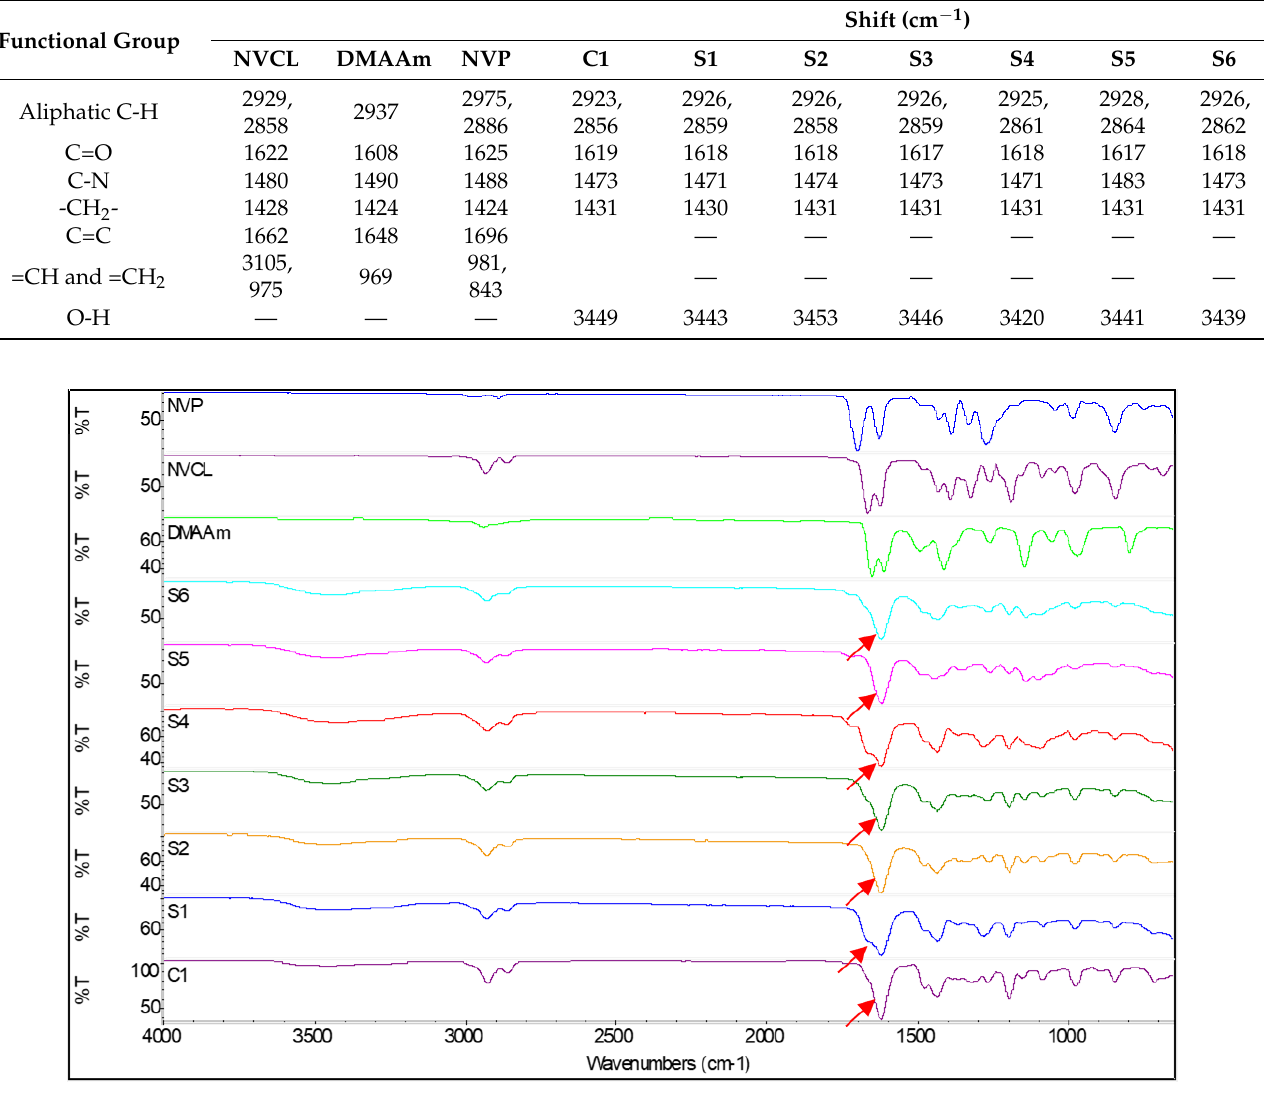
Figure 3. FTIR spectra of the constituent monomer and C1, S1, S2, S3, S4, S5, and S6 samples. Table 3. FTIR bands for NVCL and novel synthesised copolymers.